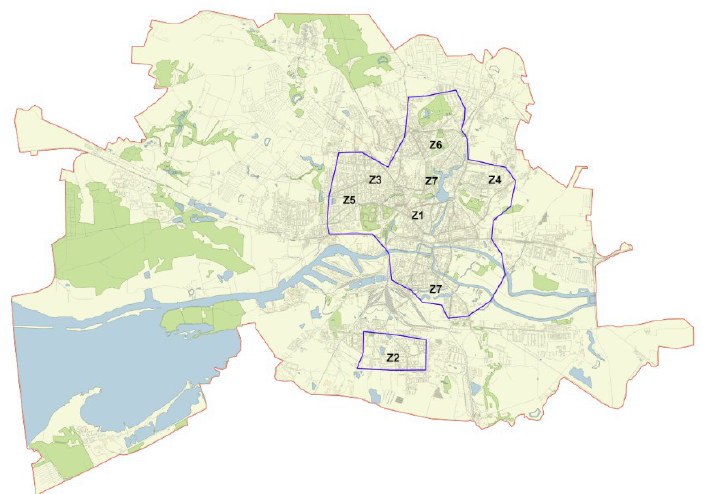
Figure 3. The map of the city Kaliningrad (red line), research area (blue line), and the research zones (Z1-Z7).